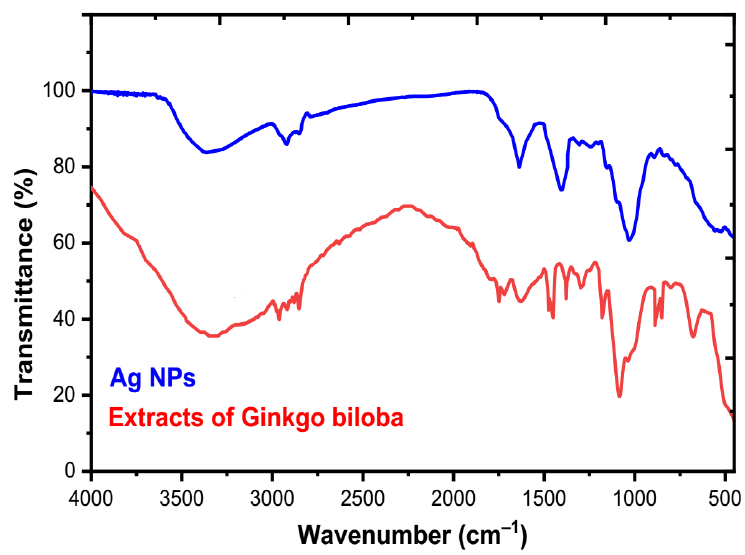
Figure 7. FT-IR s pectra of the GB extract and as-biofabricated Ag NPs. Figure 7. FT-IR spectra of the GB extract and as-biofabricated Ag